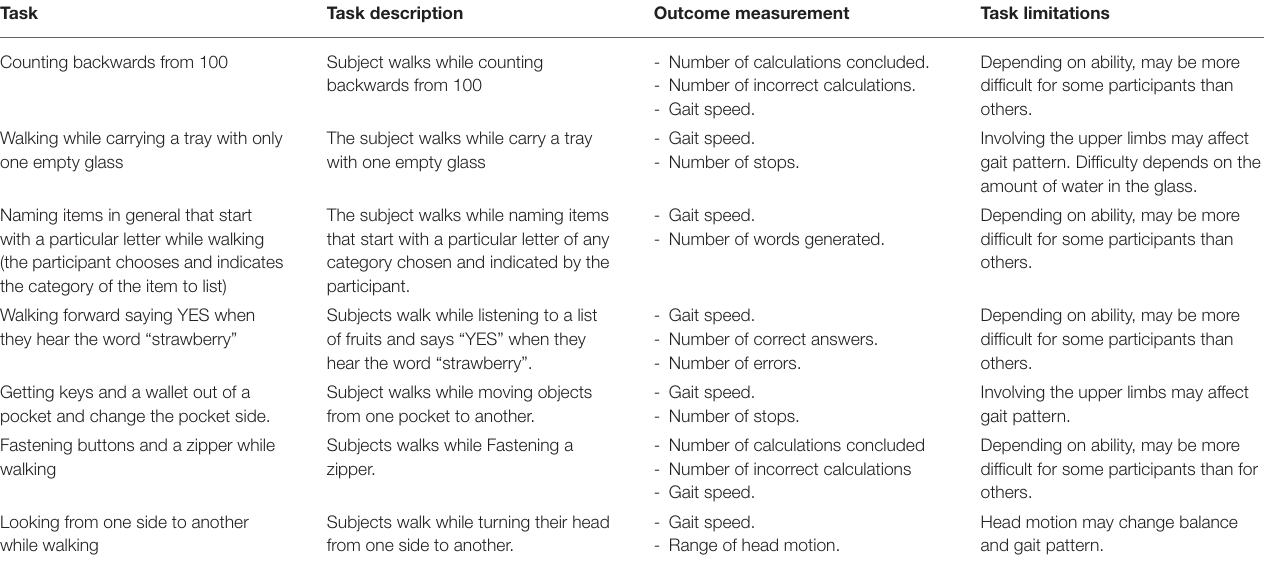
TABLE 2 | Dual-task training at difficulty level 1.